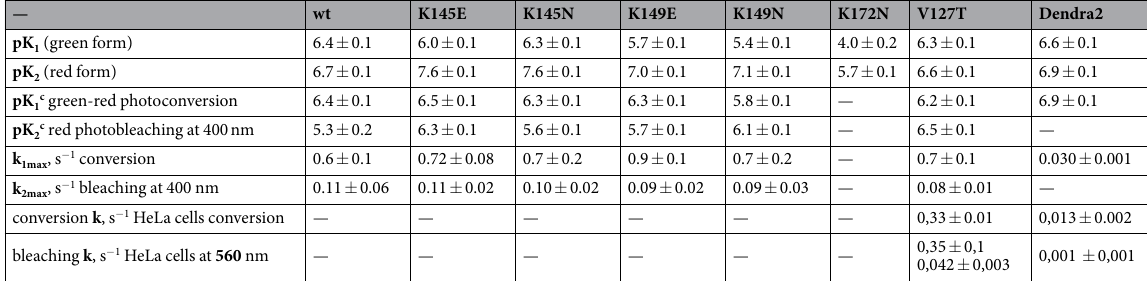
Table 4. Parameters for green and red forms of different SAASoti variants in cuvette and in live cells with standard deviation values a . a pK 1 , pK 2 describe transition from anionic to neutral forms and are measured by fitting of spectral data at different pH according to formula (1) with Origin 8.5 software package (chapter «absorbance and fluorescent measurement»). pK 1C and pK 2C calculated by regression analysis of k 1 and k 2 obtained during photoconversion experiments according to formula (2) and (3) and Figs 8 and 9 (chapter “Photoconversion”). k 1max and k 2max obtained from formula (3).